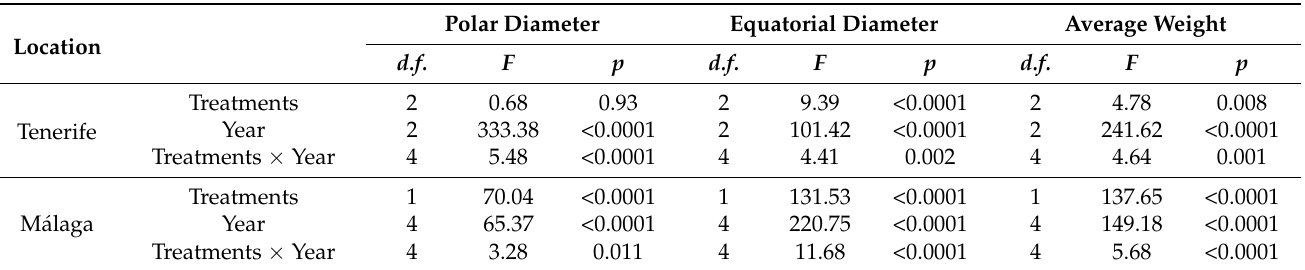
Table 6. Univariate ANOVA for average weight of fruit, polar and equatorial diameter for avocado trees subjected to three treatments over a period of three years (2011–2013) in Tenerife, and two treatments over a period of five years (2011–2015) in M á laga.